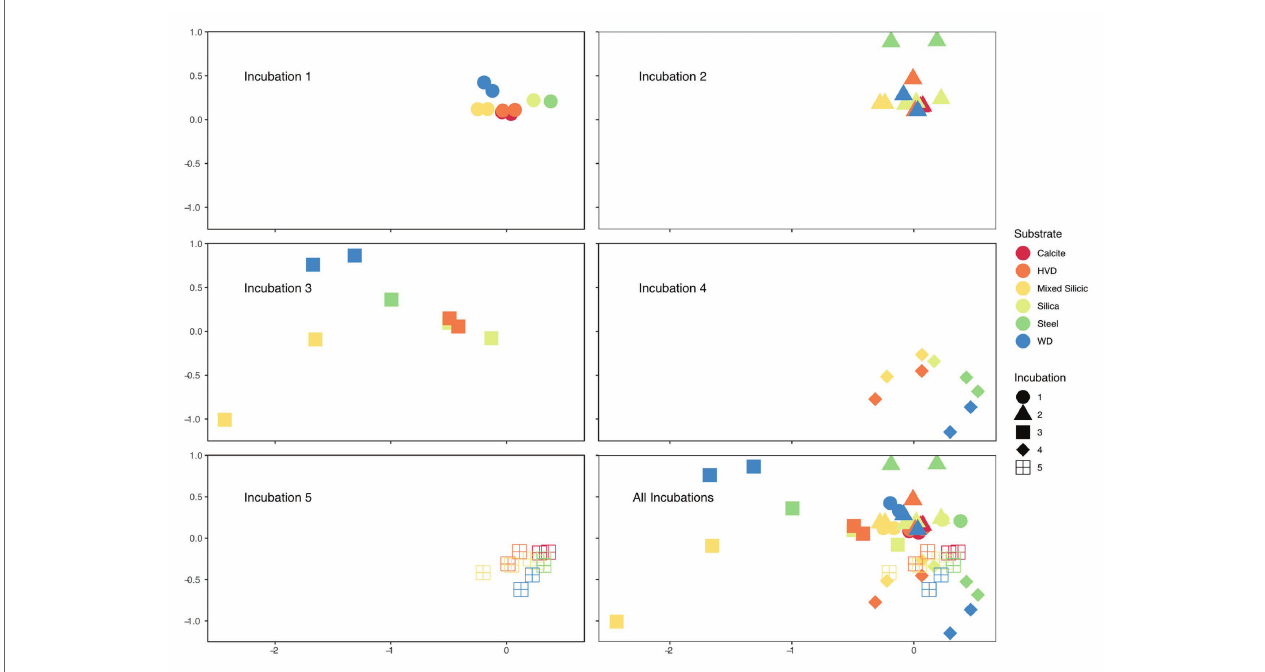
FIGURE 4 | Faceted non-metric multidimensional scaling (NMDS) of microbial relative abundance on solid substrates used in each Incubation with combined NMDS bottom right. Each point on the plot represents an individual cartridge from an incubation; two points of the same color and shape are biological replicates of substrates from the same incubation but incubated in separated cartridges in situ . Incubations 1 and 2 are the most closely related and both occurred before the addition of the organic carbon substrate. Incubation 3 represents the first samples obtained after the carbon amendment and displays the widest variation amongst biological replicates and amongst mineral substrates. Incubation 4 is dominated by methanogenic archaea which pulls the samples into a cluster toward the bottom, and by Incubation 5, the samples are again tightly clustered and close to their starting position on the NMDS